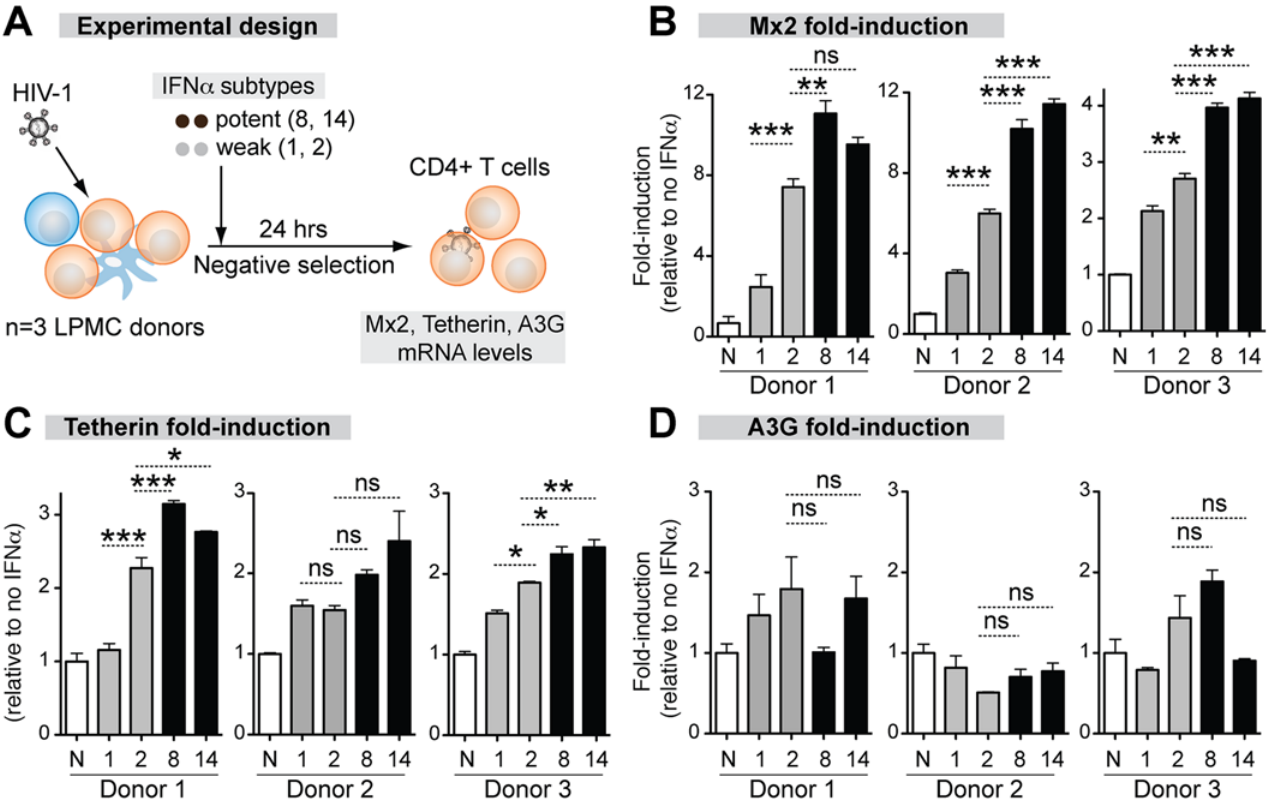
Fig 4. Correlation between ISG induction and IFN α subtype antiviral potency. (A) LPMCs (n = 3 donors) were thawed and infected with HIV-1 BaL , then treated with 100 pg/ml of weak (gray bars) and potent (black bars) IFN α subtypes. IFN α 1, IFN α 2, IFN α 8 and IFN α 14 shown simply as 1, 2, 8 and 14. After 24 hr, CD4+ T cells were negatively selected and RNA extracted for qPCR. ISGs were quantified using Taqman qPCR normalized to GAPDH levels. Mean fold- induction values and SEM error bars for (B) Mx2, (C) Tetherin/BST-2 and (D) A3G relative to no IFN α control (N) are shown for the 3 donors. Data were analyzed using repeated measures ANOVA with Dunnett ’ s multiple comparison test. Statistical support for differences in fold-induction between IFN α 1 and IFN α 2, and IFN α 2 and IFN α 8/14 are shown. ns, not significant at p > 0.05; * , p < 0.05; ** , p < 0.01; *** , p < 0.001.